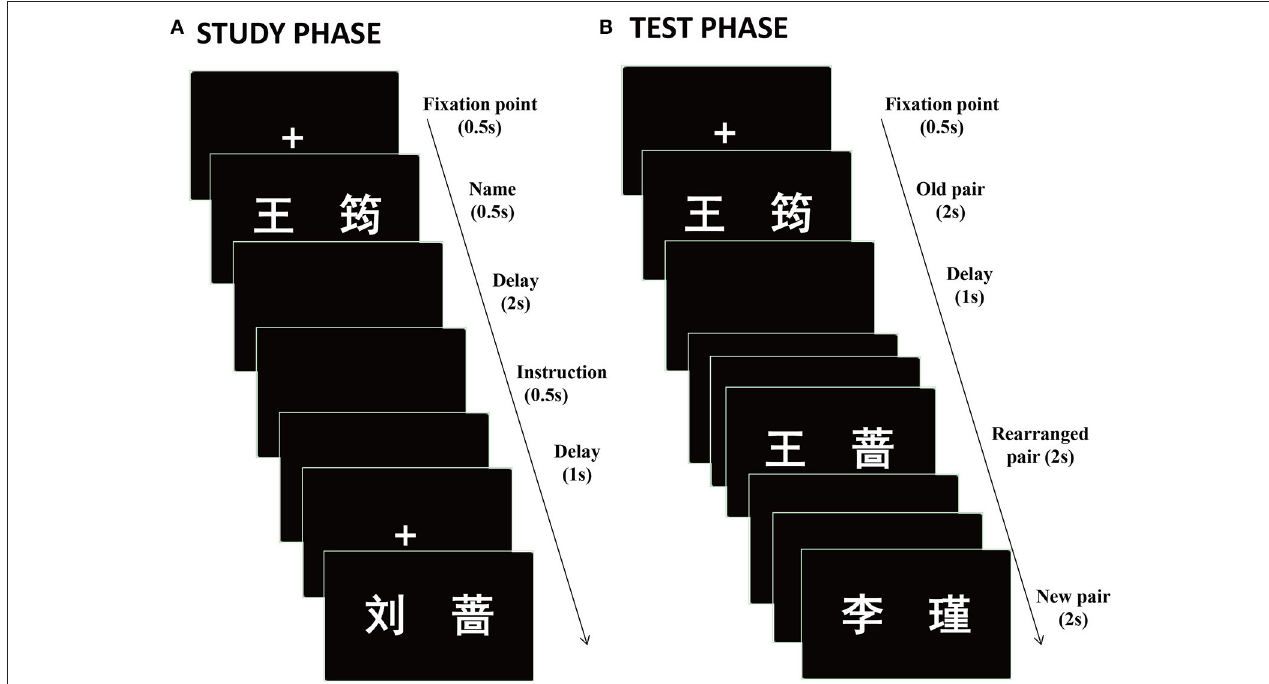
FIGURE 1 | Schematic representation of the experiment, showing examples of the stimuli. (A) Study phase, the task was to memory Chinese names according to instruction. (B) Test phase, the task was to make three kinds of judgments (“ old, ” “ rearranged ” or “ new ”).